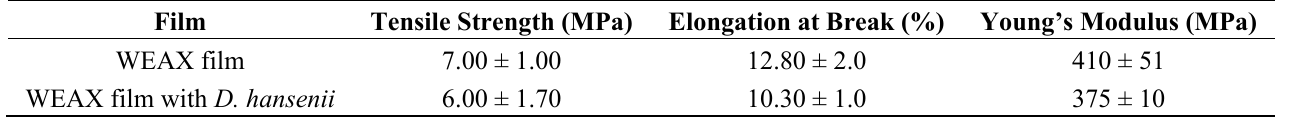
Table 3. Mechanical properties of WEAX